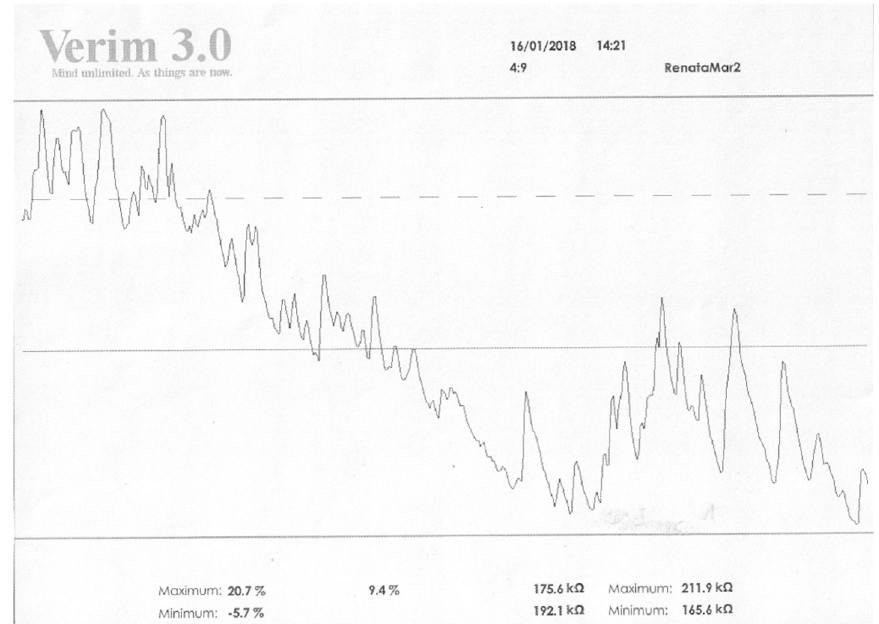
Figure 1. The results obtained in the field of EDA before the GSR Biofeedback therapy. Legend: max vs. min—values of resistance achieved by the patient in kOhm; values on the right refer to relaxation, on the left to activation. Higher values in relaxation training indicate an increase in resistance and thus an increase in relaxation; low values indicate a decrease in resistance, an increase in conductivity, and thus a decrease in relaxation. The values on the left side are the activation level. If relaxation increases, the activation of the organism decreases. Five max values vs. min are the results analogous to those presented in kOhm.